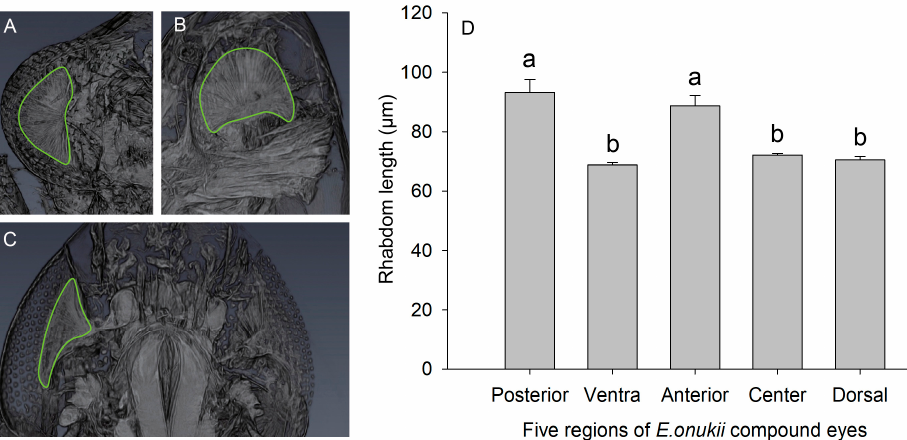
Figure 4. Internal structure and the lengths of rhabdom in five regions of the female compound eye (mean ± SE). ( A ) From top to bottom: dorsal, central, and ventral. ( B ) From left to right: ventral, central, and dorsal. ( C ) From top to bottom: anterior, central, and posterior. ( D ) Rhabdom lengths in five different regions. The marked area in A–C is the rhabdom. The different lowercase letters in D indicate significant differences ( p < 0.05, one-way ANOVA).